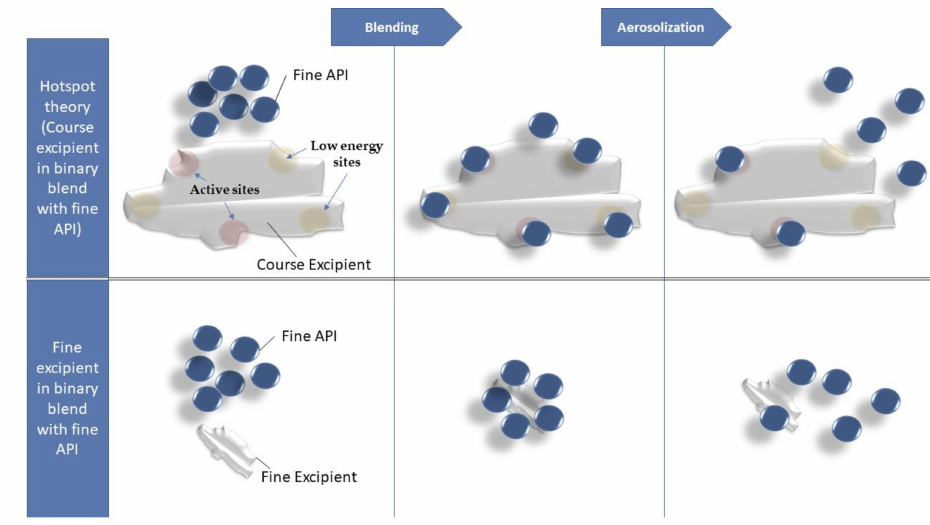
Figure 10. Schematic diagram of particles’ agglomeration / deagglomeration behavior upon blending / aerosolization respectively between course excipients verses fine-sized excipients in dry powder inhaler (DPI) binary